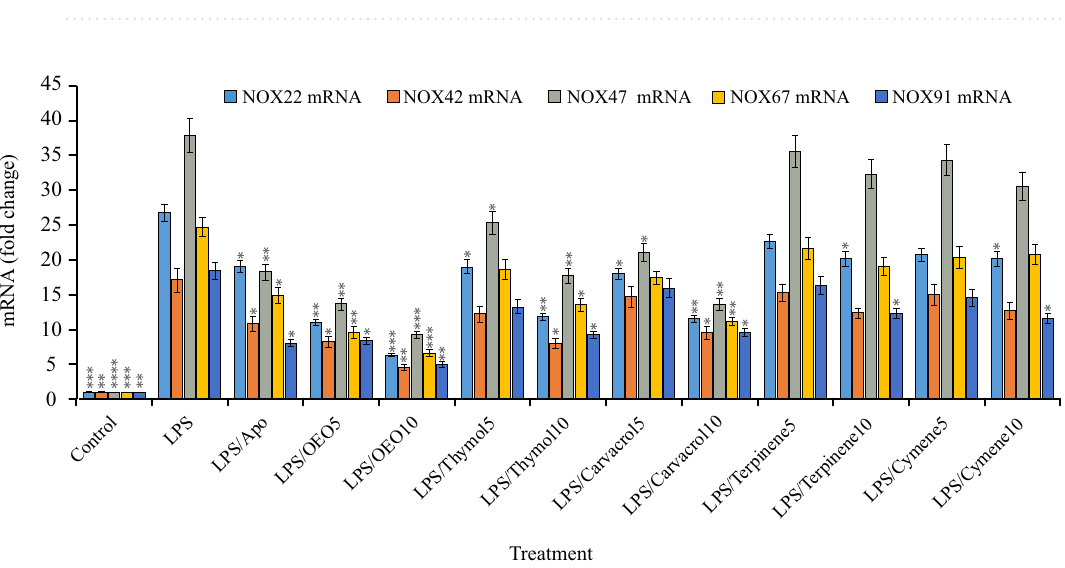
Table 3. Effects of OEO, main components, and positive control (apocynin) at different concentrations (5 and 10 µg/ml) on ROS production and NOX activity in LPS-stimulated macrophages. The values are expressed as means ± SDs for three replicate experiments. Mean values with different letters within a column are significantly different by the Tukey test at ( p < 0.05). This test classifies the groups into letters. Groups that have little significant difference have similar letters and those with more significant difference receive different letters.